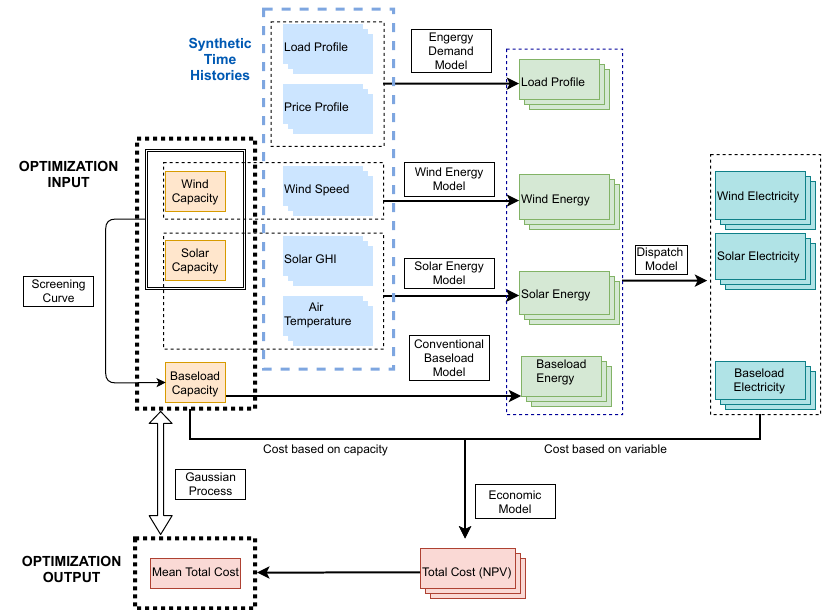
Figure 1. Calculation